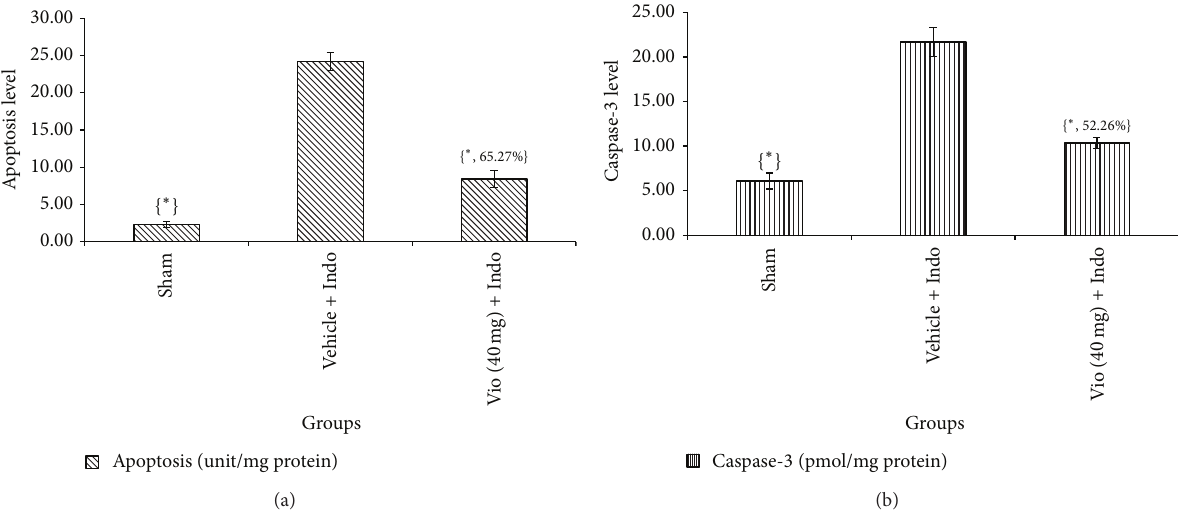
Figure 10: (a) Effect of violacein (40mg/kg, orally) on apoptosis level; (b) caspase-3 level in indomethacin-induced ulcerated rats. Values are mean ± SD ( n = 6). ∗ 𝑃 < 0.05 compare Vehicle + Indo with all the groups. Values in the braces indicate apoptosis and caspase-3 level inhibition percentage. Indo: indomethacin; Vio: